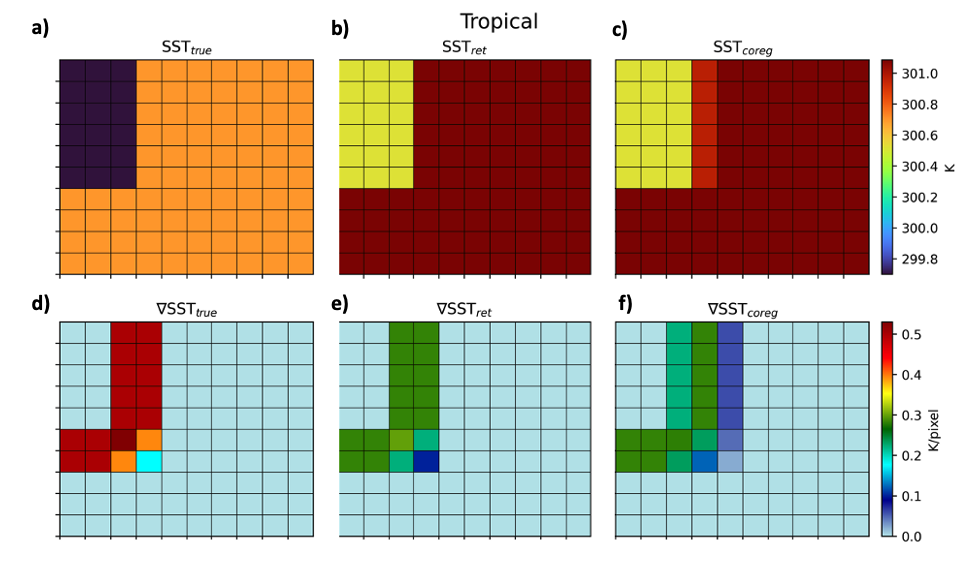
Figure 1. ( a ) Reference synthetic SST field (SST true ); ( b ) SST field retrieved via the NL split-window algorithm of [31]; ( c ) SST retrieved via the NL split-window algorithm considering the co-registration on the Harmony TIR-1 channel (SST coreg ). Gradient magnitude of the ( d ) SST true ; ( e ) SST ret field; ( f ) SST coreg